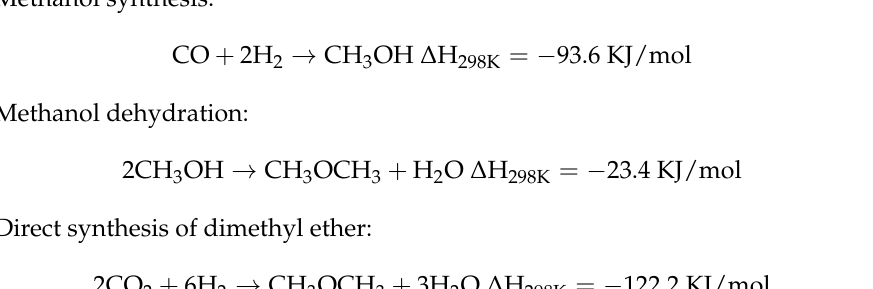
Figure 13. Two pathways for DME production: direct and indirect. Adapted with permission from [209], Elsevier, 2018.